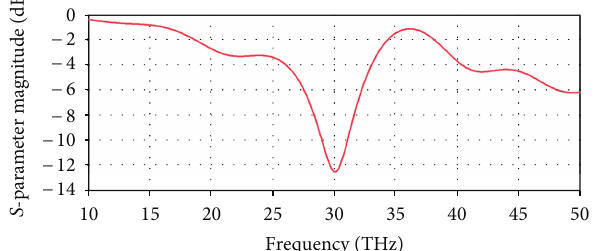
Figure 12: Magnitude of input reflection coefficient for modified